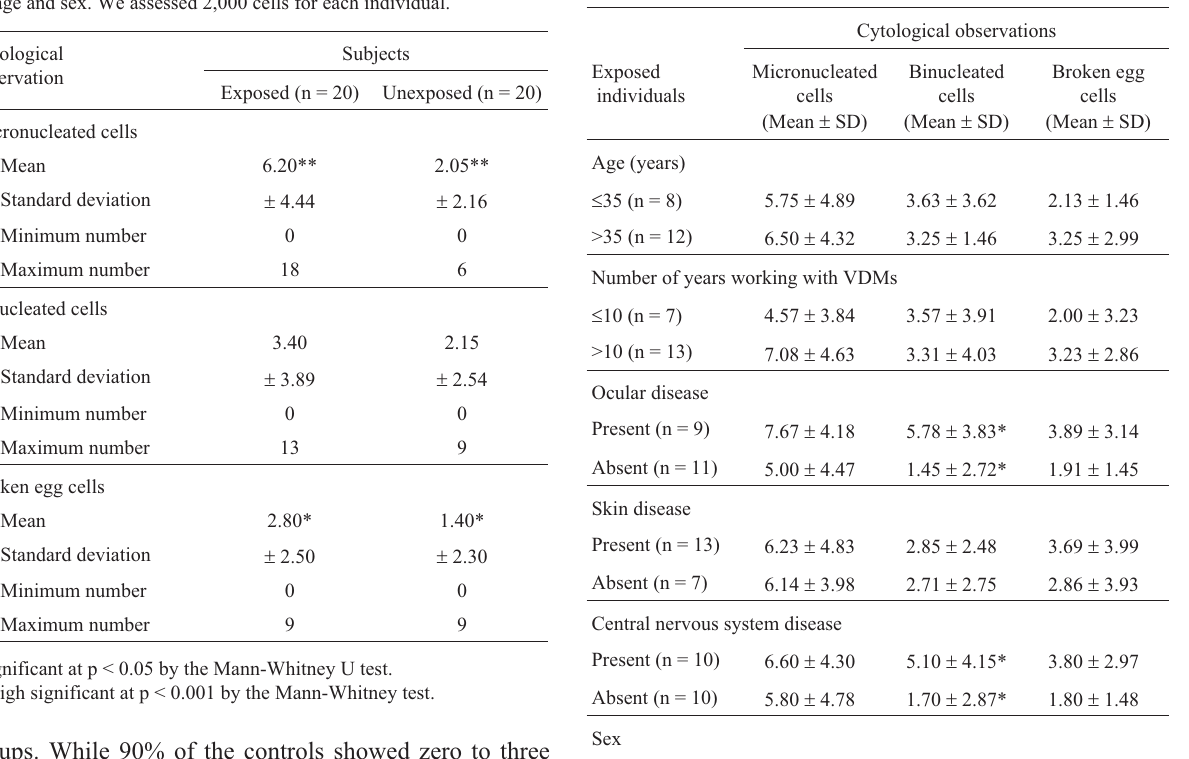
Table 3 - Cytological observations made on 10 males and 10 females occupationally exposed to cathode ray tube computer video display monitors (VDMs). We assessed 2,000 cells for each